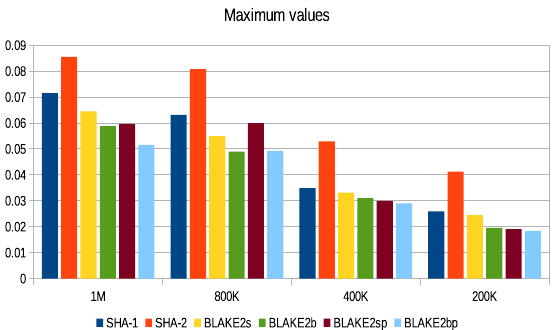
Figure 20. Maximum execution time of hash functions with different data sizes.